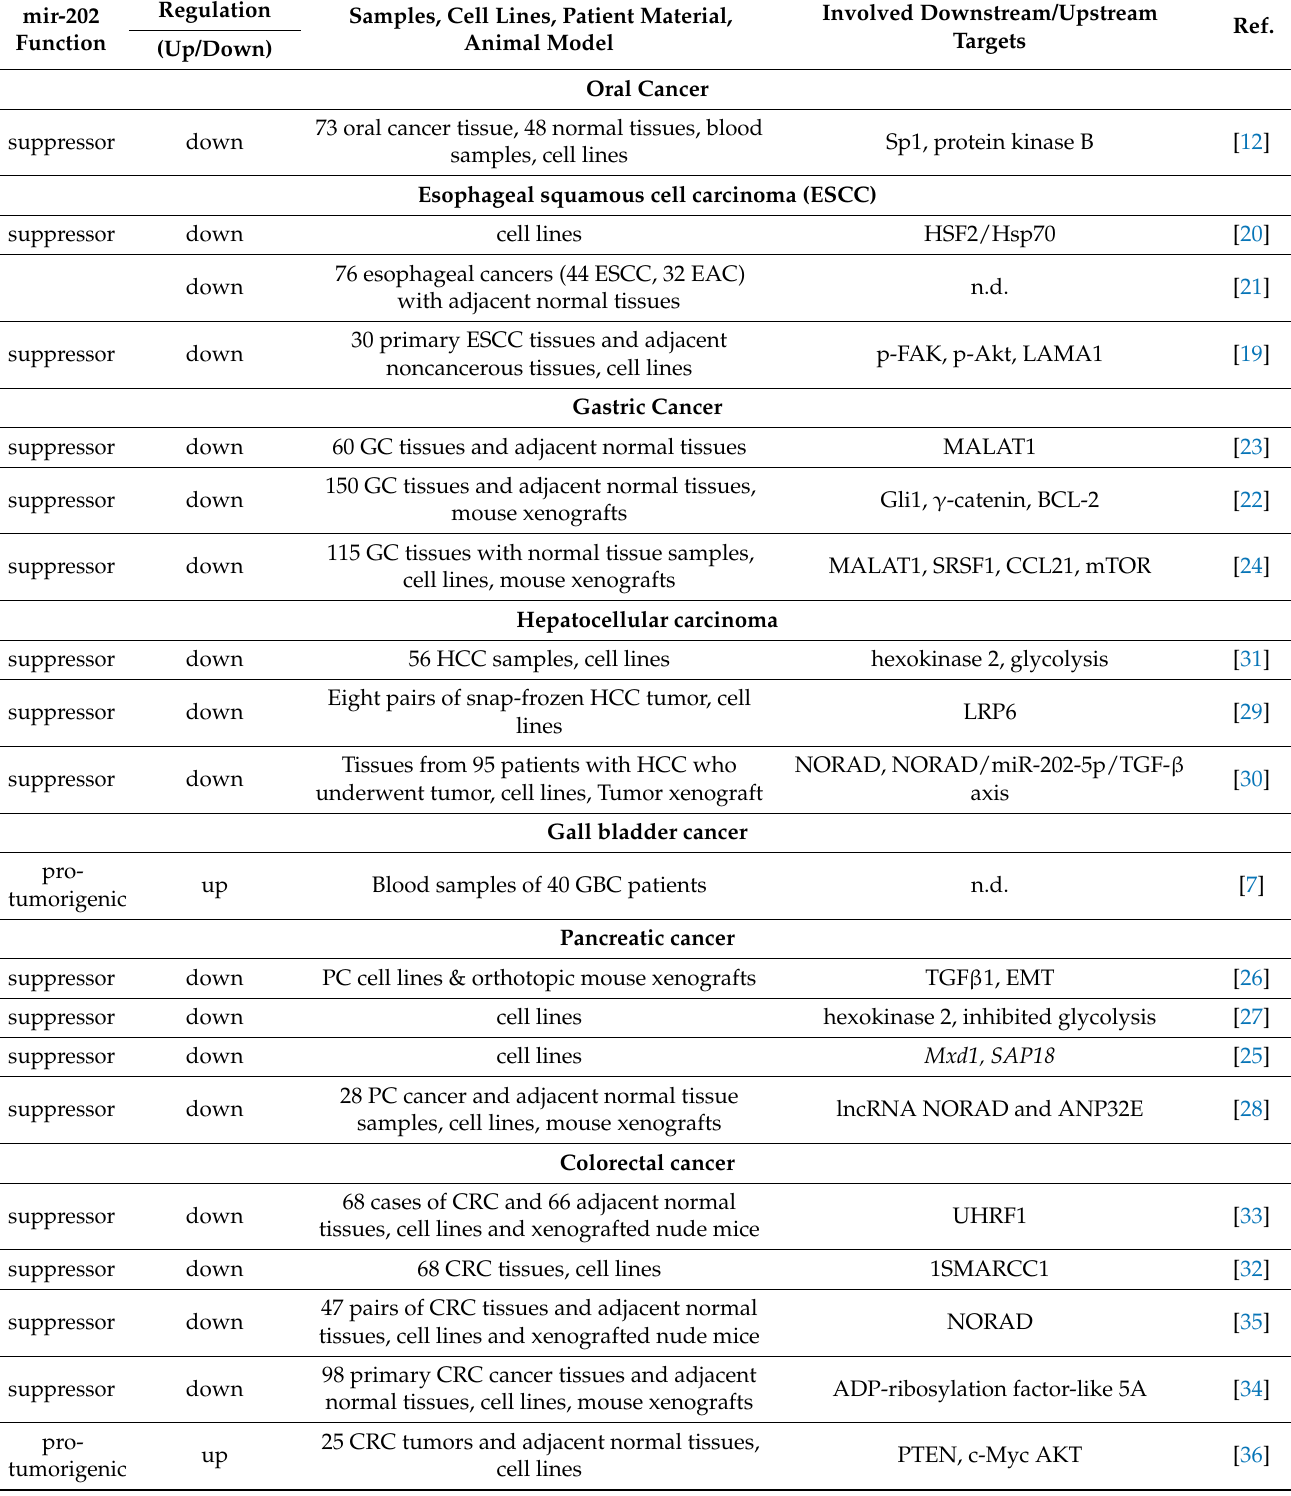
Table 2. The suppressive function of miR-202 in different types of digestive tract